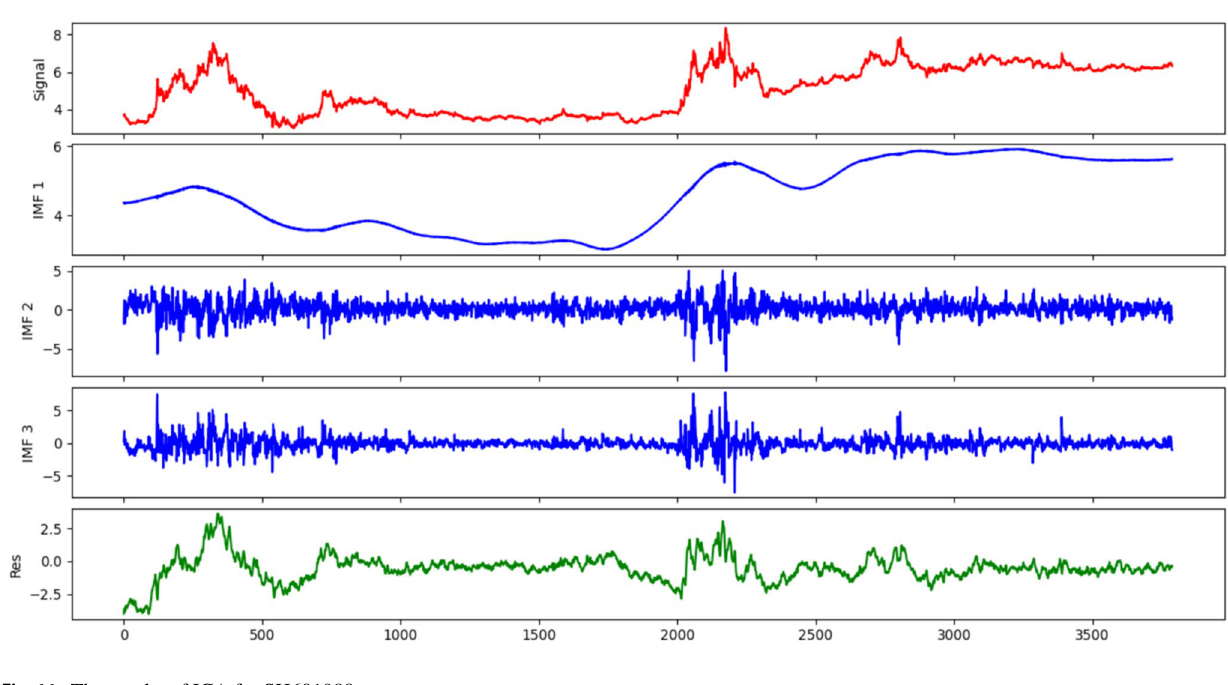
Fig. 11 The results of ICA for